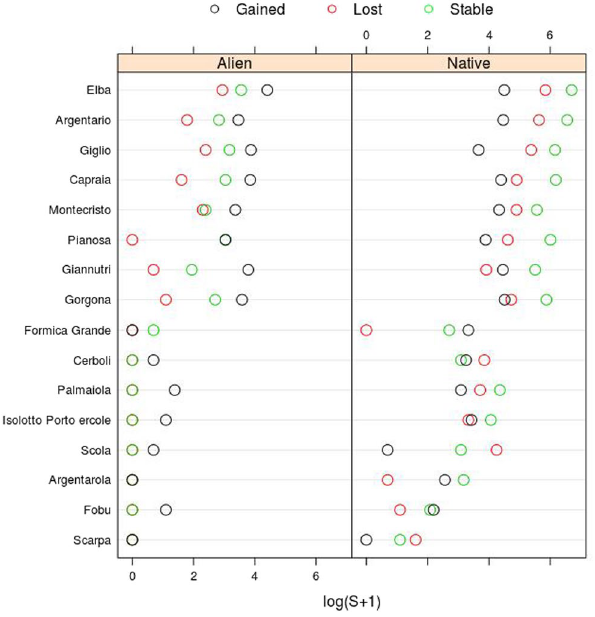
Figure 3. Number of alien and native species that remained stable (green), were gained (black), or were lost (red) in the flora of each island from the first period (1830–1950) to the second period (1951–2015).